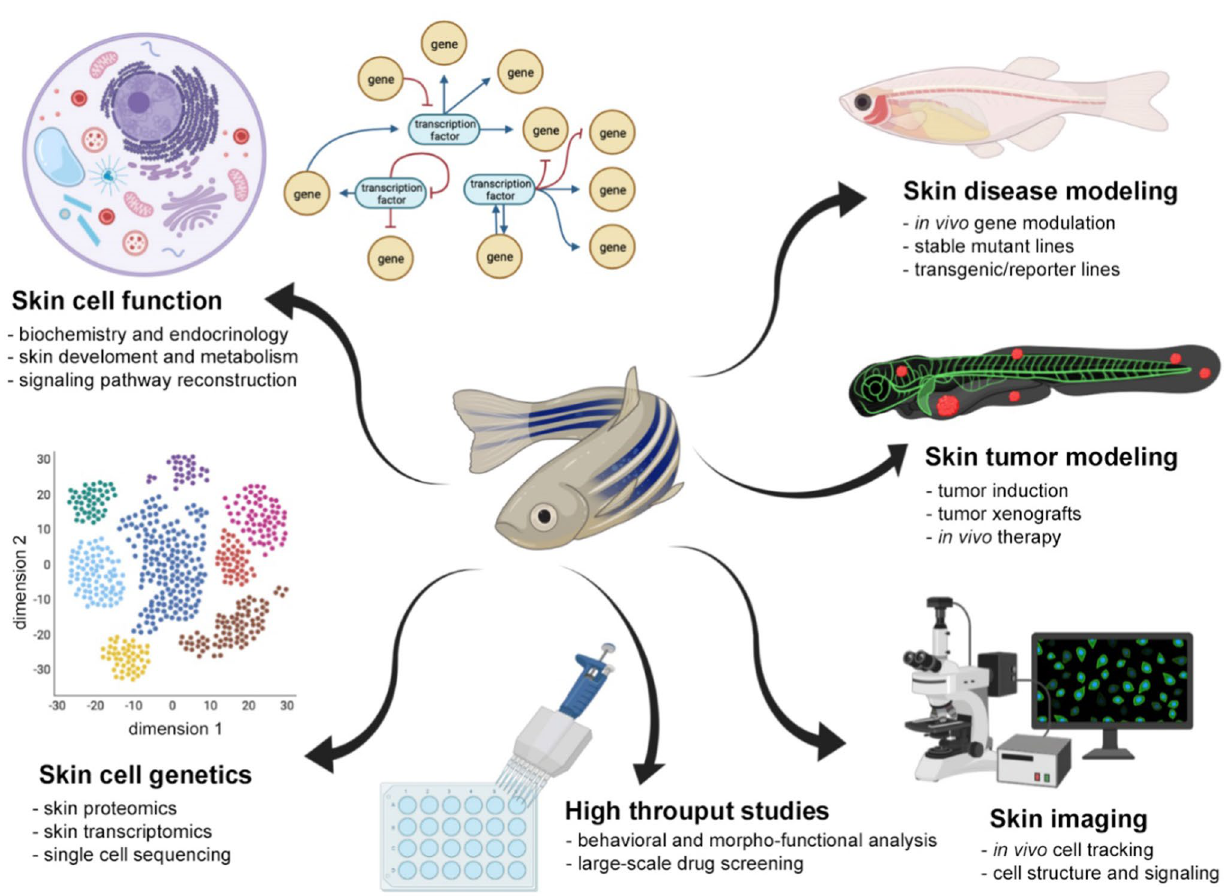
Fig. 2 Zebrafish applications in skin biology. Examples of applications of thezebrafish model in the field of skin biology include skin disease and tumormodeling, biochemical and genetic tests, drug screen and in vivo imaging, all suitable for large-scale studies. Imagescreated with